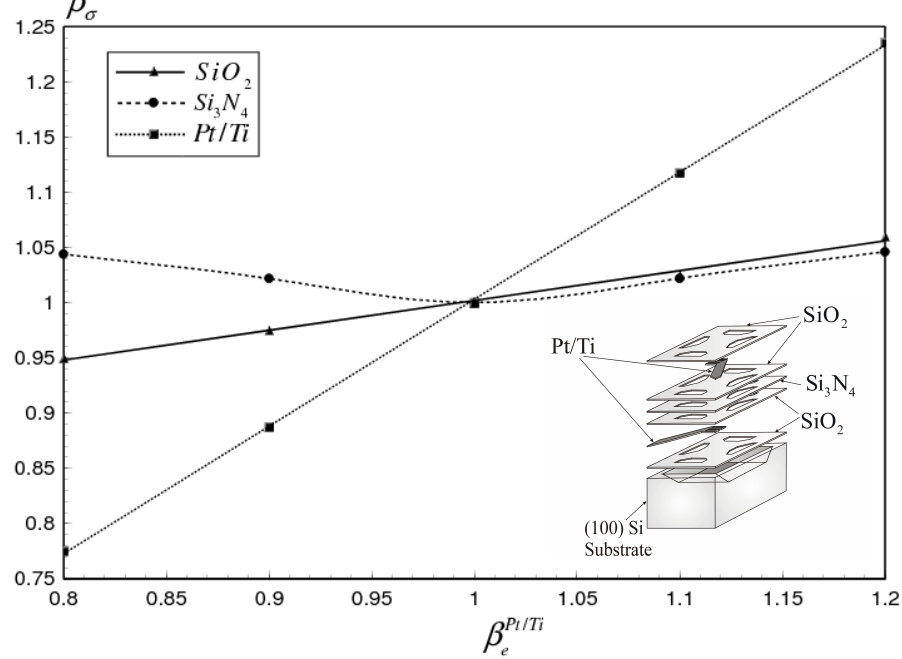
Figure 9. Effect of the variation of the coefficient of thermal expansion of PtTi on the maximum thermal stress of different gas sensor